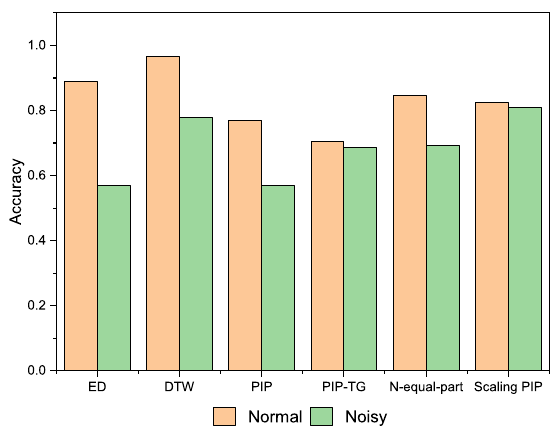
Figure 14. The overall accuracy on different synthetic data. The ED and DTW performs well when the noise level is low, but the accuracy declines a lot as the noise increases. The results of the scaling PIP are similar to the one in Figure 11. It barely changed with the noise level and that indicates that the scaling PIP is much more robust than the distance-based